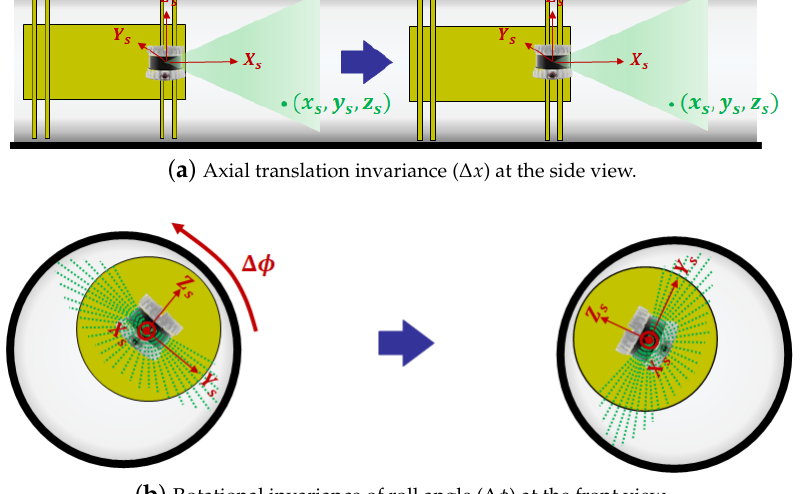
Figure 3. Transformation invariance of 3-D point cloud in a cylindrical pipe.